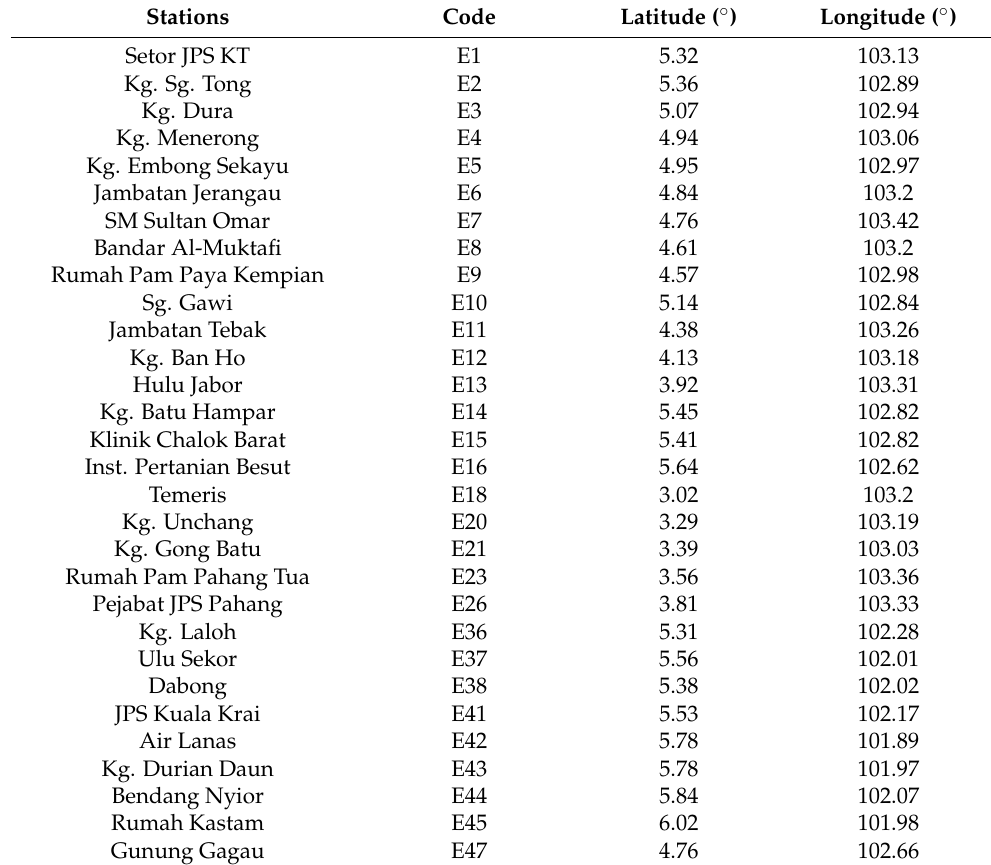
Table 1. Geographicalcoordinatesoftheobserved30rainfallstationsontheeastcoastofPeninsularMalaysia.